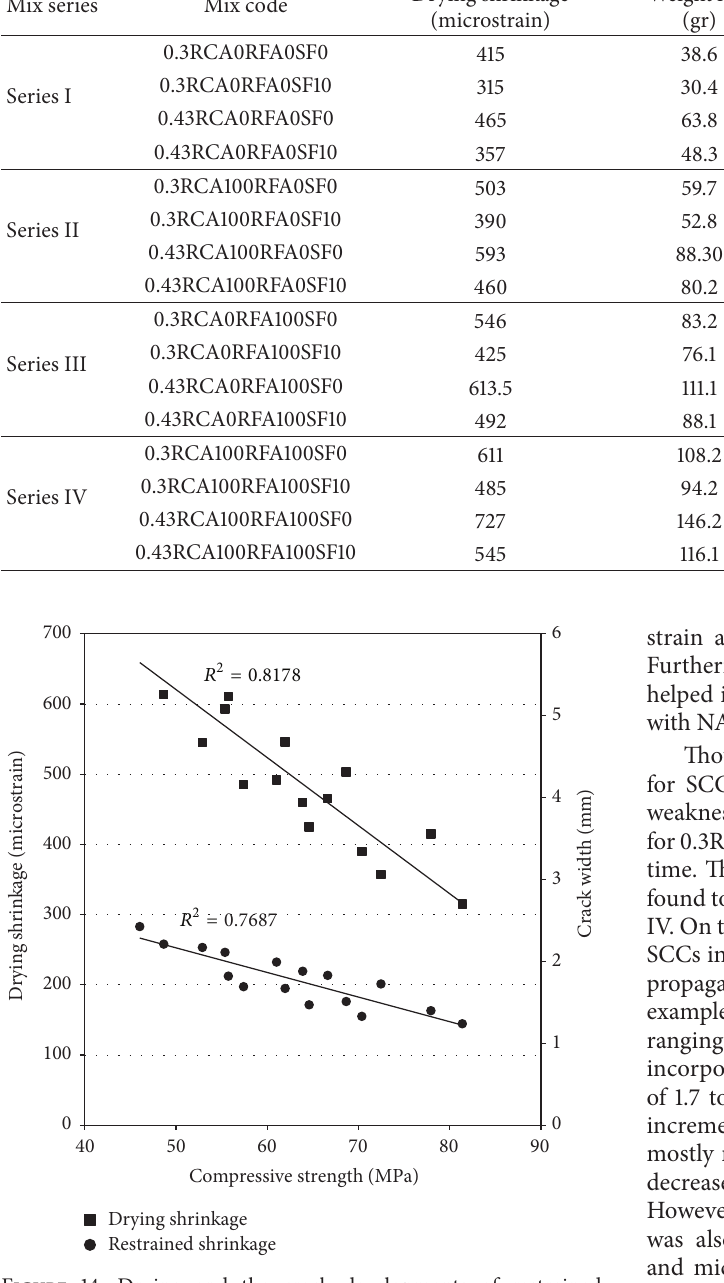
Figure 14: Drying and the crack developments of restrained shrinkage specimens within time of SCCs versus with compressive